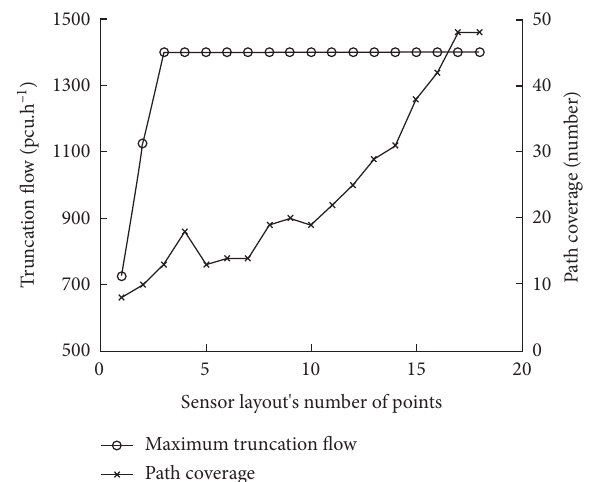
Figure 3: Maximum truncation flow change with number of points.